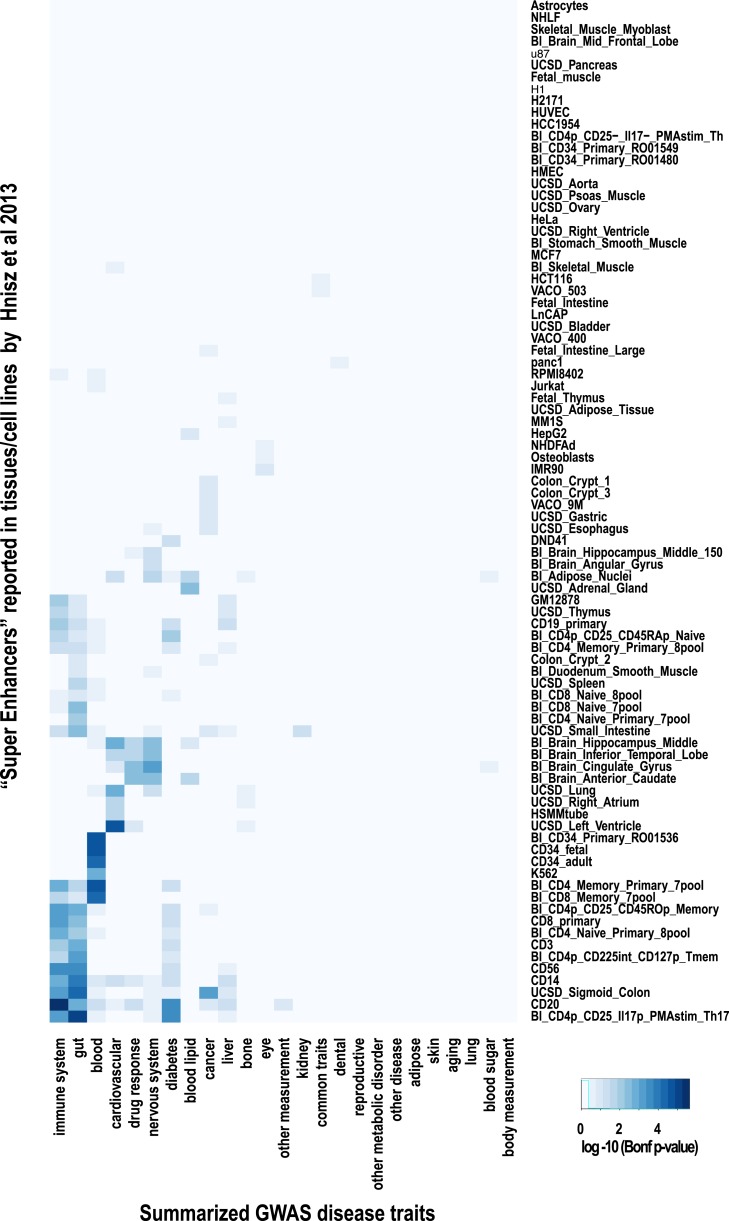
Super-enhancer enrichments obtained by GWAS lead SNPs.‘Super-enhancers’ were directly obtained from Hnisz et al. (2013) and overlapped with lead GWAS SNPs annotated in the NHGRI catalogue (Hindorff et al., 2009). Each lead GWAS SNP was given a 5-kb window prior to identify overlapping ‘Super Enhancers’. The heatmap shows hierarchical clustering of the −log10 of corrected p-values for the enrichments of super-enhancers. A Hypergeometric test with Bonferroni correction was employed to assess the significance of enrichments in all categories. The heatmap shows significant enrichment of lead SNPs by immune cell super-enhancers. Super-enhancers from the liver cancer cell line HepG2 were not enriched for liver-related GWAS lead SNPs but were enriched for blood lipid related SNPs.